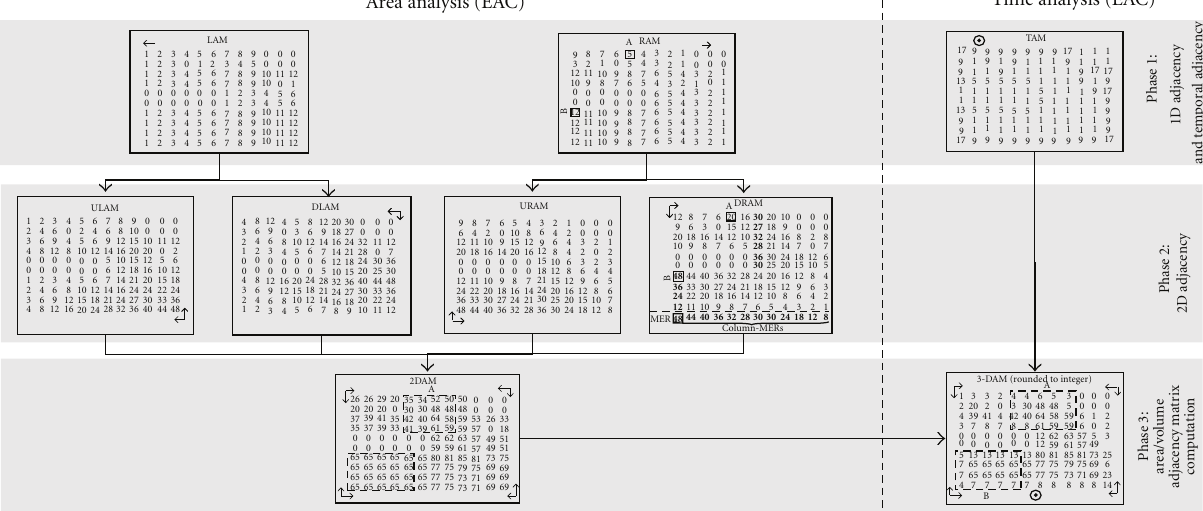
Figure 8: EAC and EVC heuristics